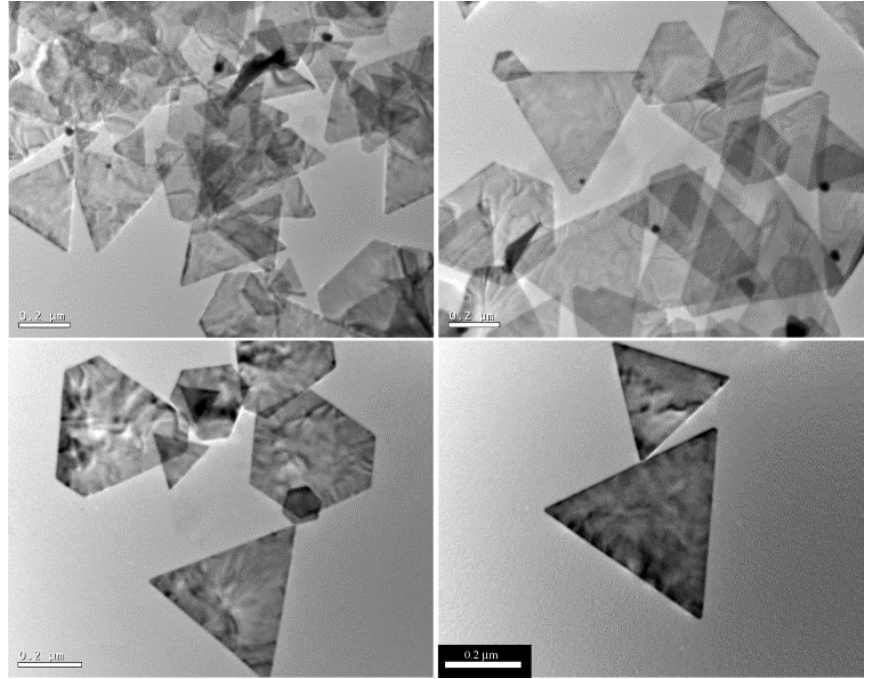
Figure 3. TEM images of gold nanoplates synthesized under the following experimental conditions: 5 mL of 1-day aged aqueous Sargassum extract + 5 mL of deionized H 2 O + 1 mL of 10 mM HAuCl 4 aqueous solution, pH 7, room temperature for 3 h. All scale bars are 200 nm. Reproduced from Reference [44]. Copyright (2005) American Chemical Society.